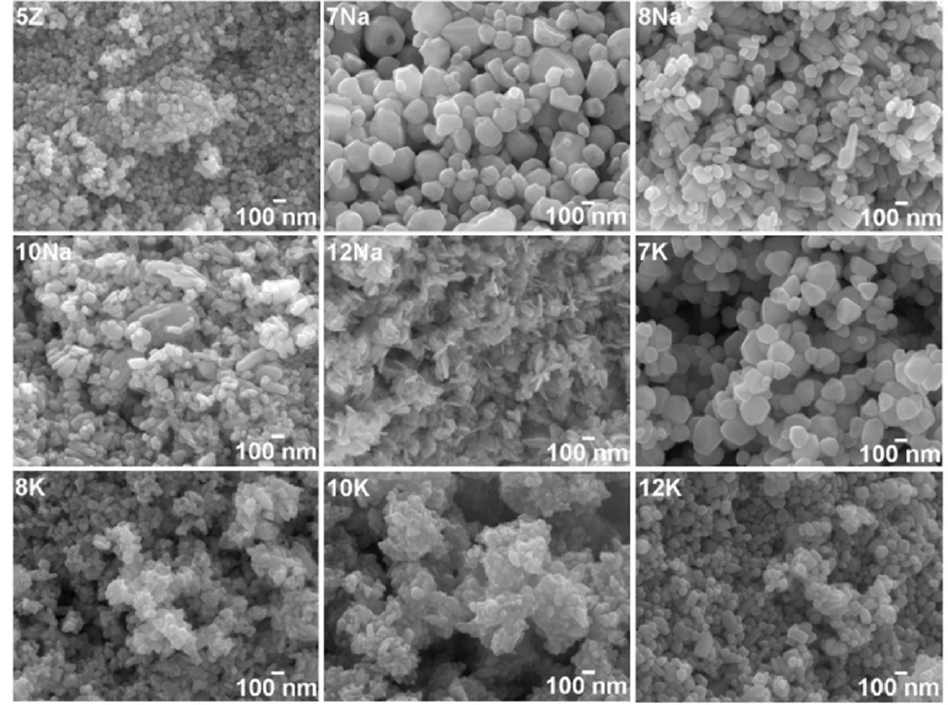
Figure 3. Typical SEM images of synthesized ZnO nanostructures at different reaction pH values. Reprinted/adapted with permission from Ref. [65]. Copyright © 2022, Elsevier Ltd and Techna Group S.r.l.